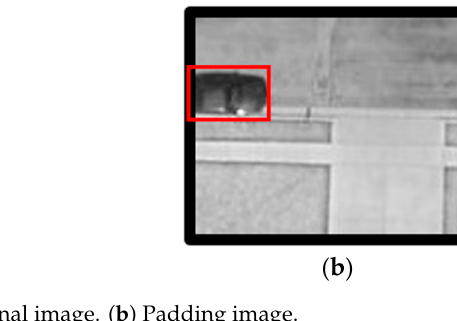
Figure 4. Two annotation methods: ( a ) sample of annotation 1. ( b ) sample of annotation 2. By observing a large number of dataset labels, it has been found that many vehicles are at the